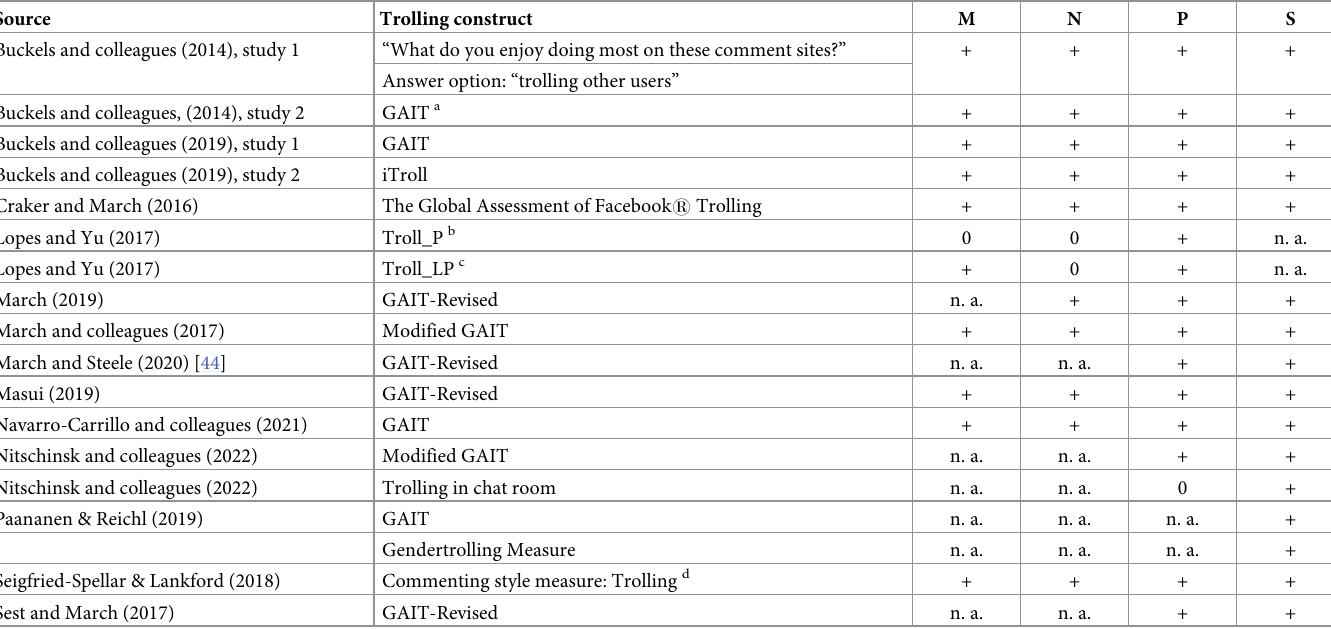
Table 1. Correlations between trolling assessments and the dark tetrad